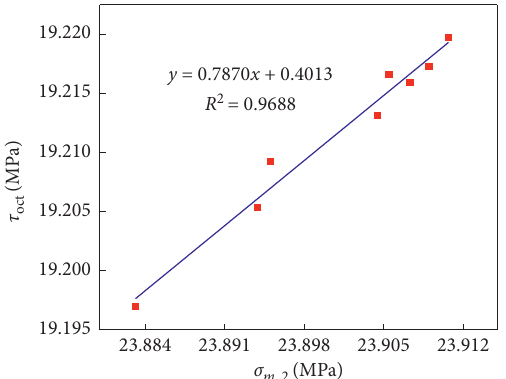
Figure 5: τ - σ m, relationship of true triaxial unloading test. oct 2